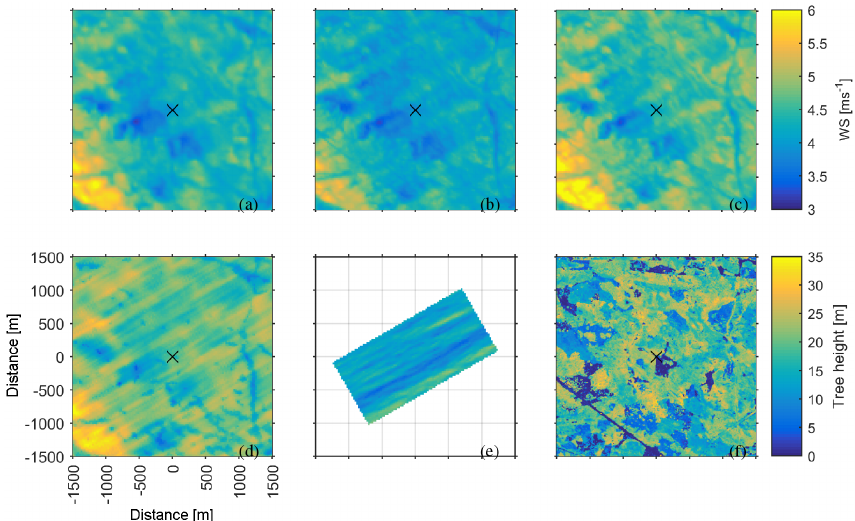
Figure 7. (a–e) Simulated wind speed at 40m above the local ground height. (a) EllipSys3D high-resolution 1, (b) Alya, (c) OpenFoam CFDWind, (d) OpenFoam UUCG, and (e) PALM. The size of the boxes is 3km × 3km centred around the measurement tower (marked by an × ). (f) The forest